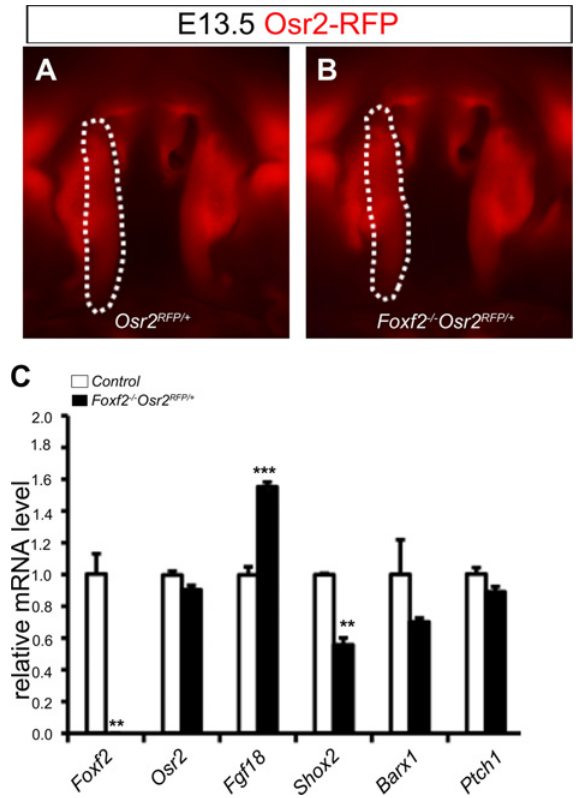
Fig 4. Differential gene expression analysis of palatal mesenchyme cell in control and Foxf2 mutant embryos by using RNAseq and real time RT-PCR assays. (A, B) The patterns of RFP expression in the Osr2 RFP/+ (A) and Foxf2 -/- Osr2 RFP/+ (B) palatal shelves are comparable. White dashes demarcate the palatal shelf on the right side. (C) Real time RT-PCR analysis of the levels of expression of Foxf2 , Osr2 , Fgf18 , Shox2 , Barx1 , and Ptch1 mRNAs in E13.5 palatal mesenchyme cells in control and Foxf2 -/- Osr2 RFP/+ embryos ( ** p < 0.01, *** p <